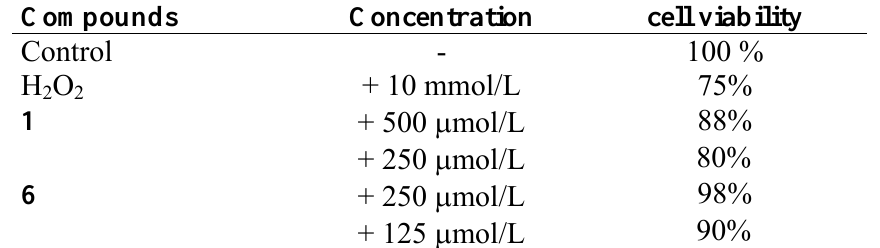
O -induced cytotoxicity in Caco-2 cells. 2 2